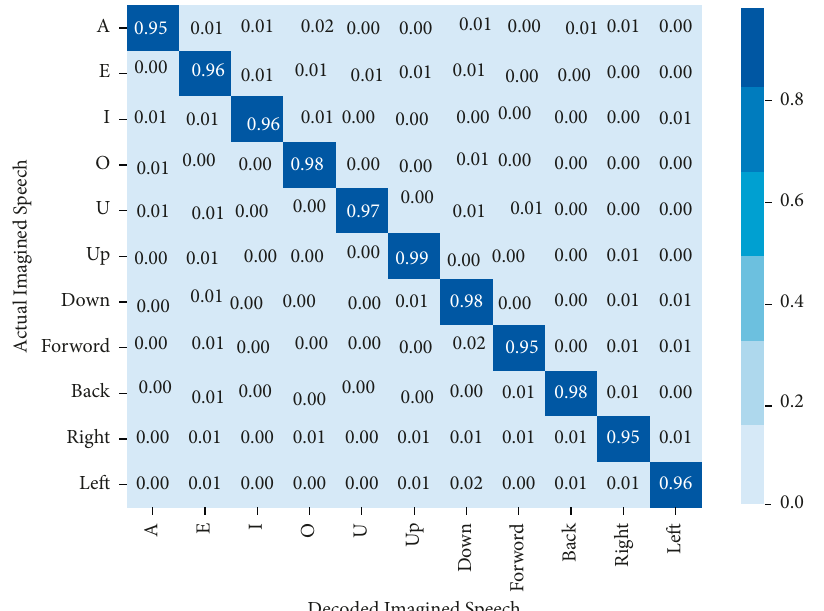
Figure 5: The model evaluation confusion matrix. The column represents the ground truth of the actual speech, and the row represents the predicted speech by the model. The diagonal from top-left to bottom-right represents the true positive for each speech label.